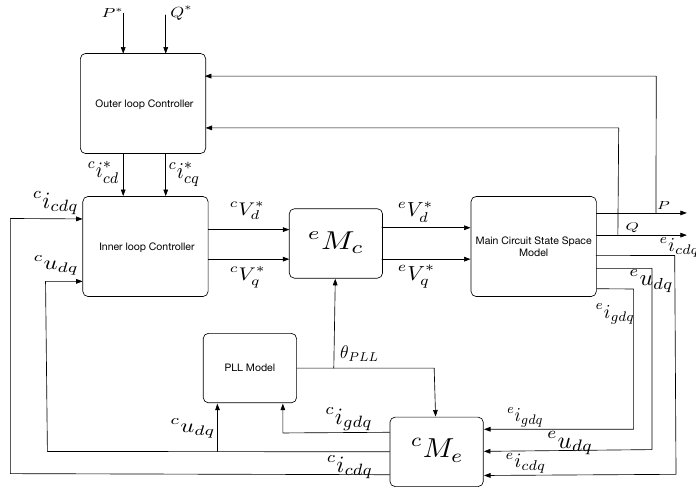
Figure A1. Block diagram for the nonlinear mathematical